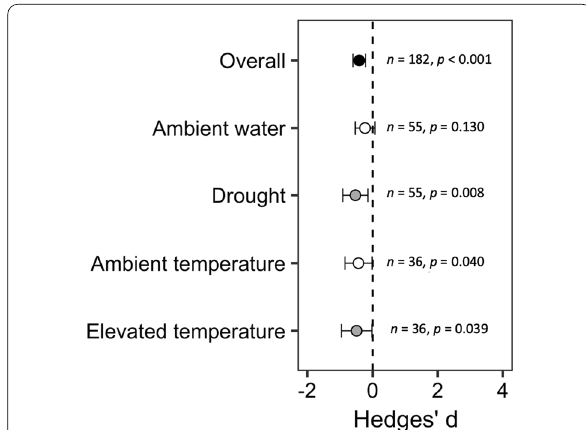
Fig. 2 Main effects of temperature and drought on PSFs. ‘Overall’ indicates the pooled effect size across all studies. Mean PSFs effect size is presented with 95% CIs. Mean PSFs effect size is significantly different from zero if the corresponding CIs do not overlap with zero (dashed line). n represents the total number of observations used during analysis and p indicated whether mean PSFs effect sizes were significantly different from zero. Hedges’ d : 0 for no effect, 0.2 for − small ( 20%), 0.5 for medium ( 50%), 0.8 for large (-80%) and − − − − > 1.0 (> 100%) for strong large negative effects, −